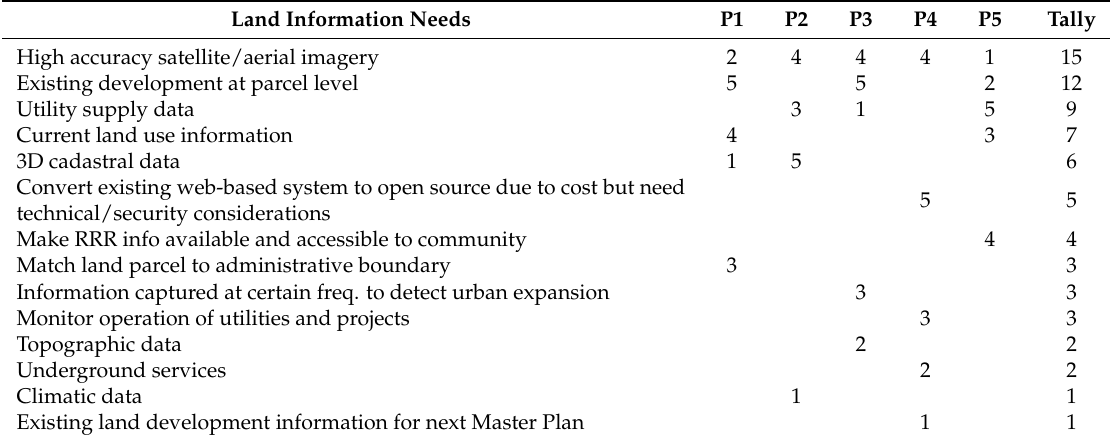
Table 2. Example of NGT workshop outcome in the its4land project (five participants, first round voting). Land Information Needs P1 High accuracy satellite/aerial imagery Existing development at parcel level